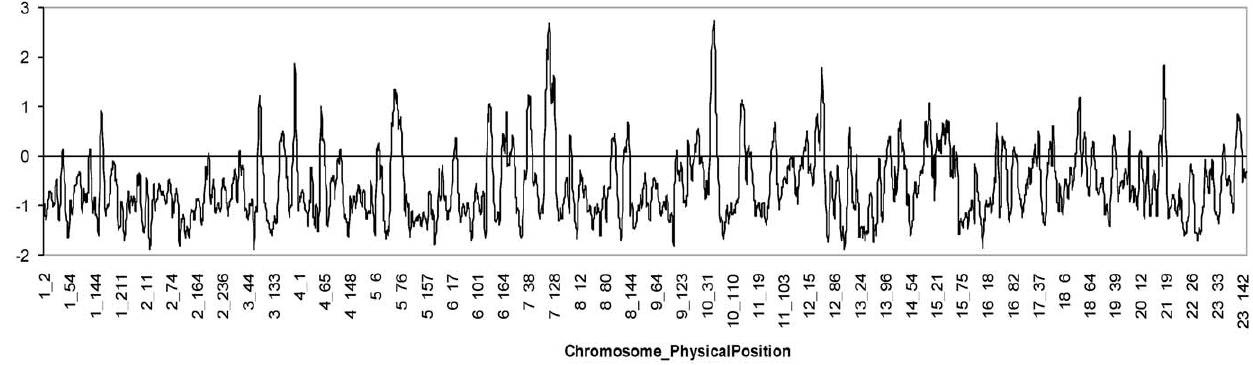
Figure 4. Distribution of LOD-scores for disease association along the genome in the Antioquian T2D admixture mapping scan.